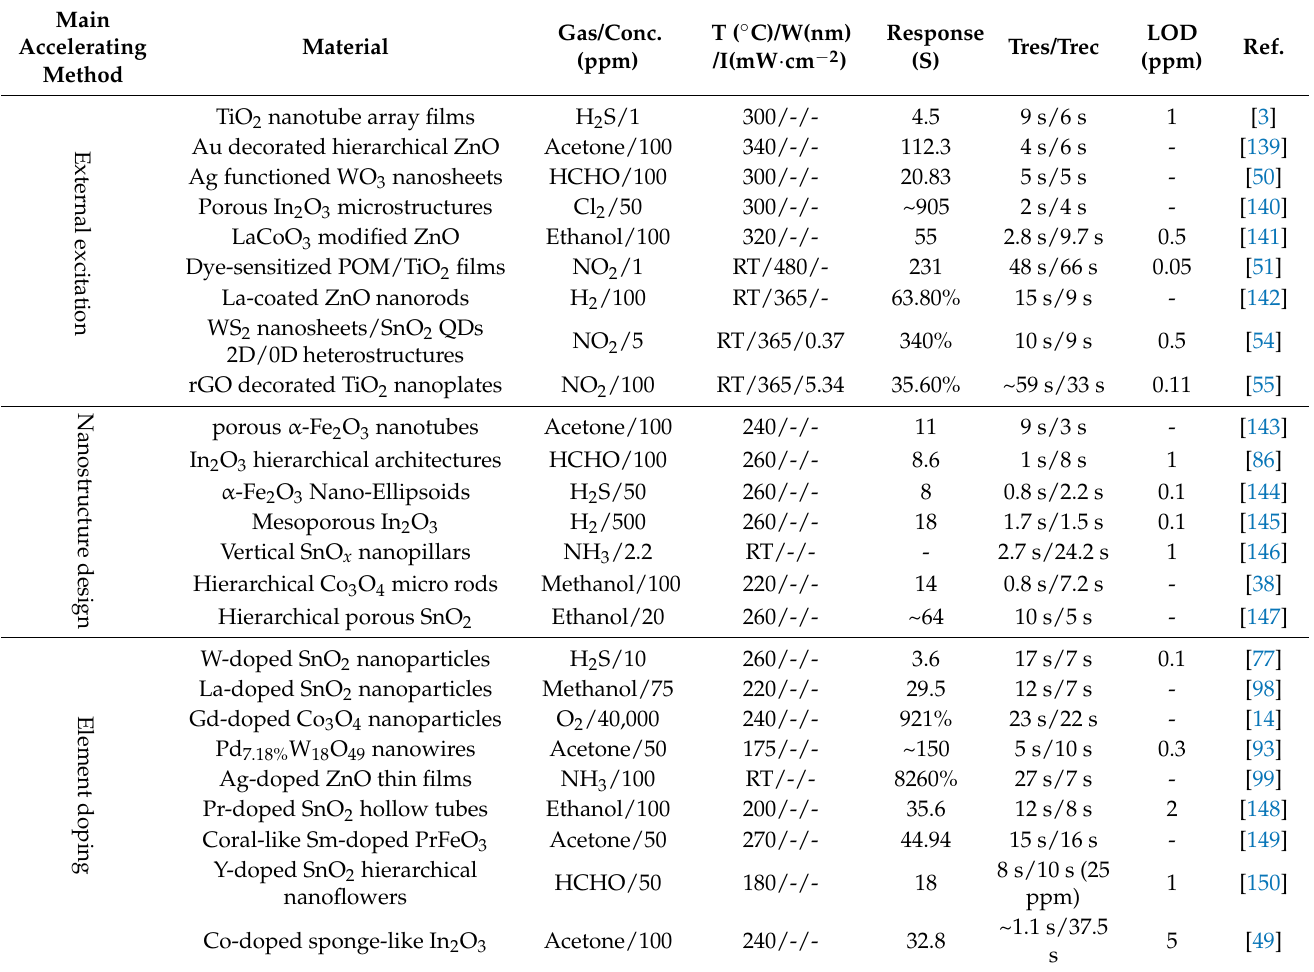
Table 2. List of various main efforts applied to accelerate response/recovery of gas